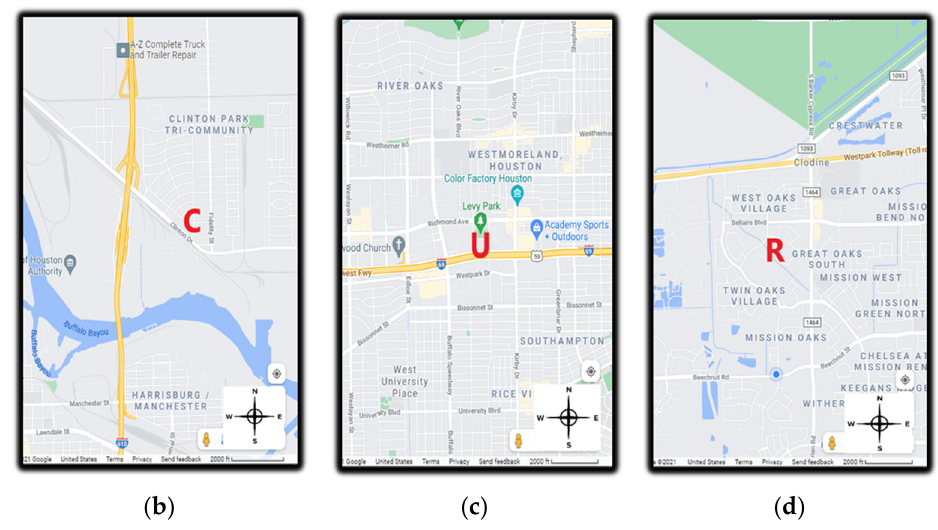
Figure 1. Map showing sampling locations. ( a ) All 3 sampling locations; ( b ) Clinton drive sampling location (Latitude: 29.7340345, Longitude: − 95.2581138); ( c ) US—59 sampling location (Latitude: 29.731556, Longitude: − 95.424426); ( d ) Residence sampling location (Latitude: 29.6854160, Longitude: − 95.6937728). C = Clinton Drive; U = US-59; R = Residence. Map source: Google Maps.